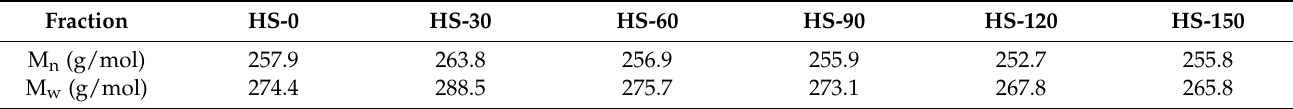
Table 3. Changes in the molecules of the TS fraction of pitch incubate for 150 days.